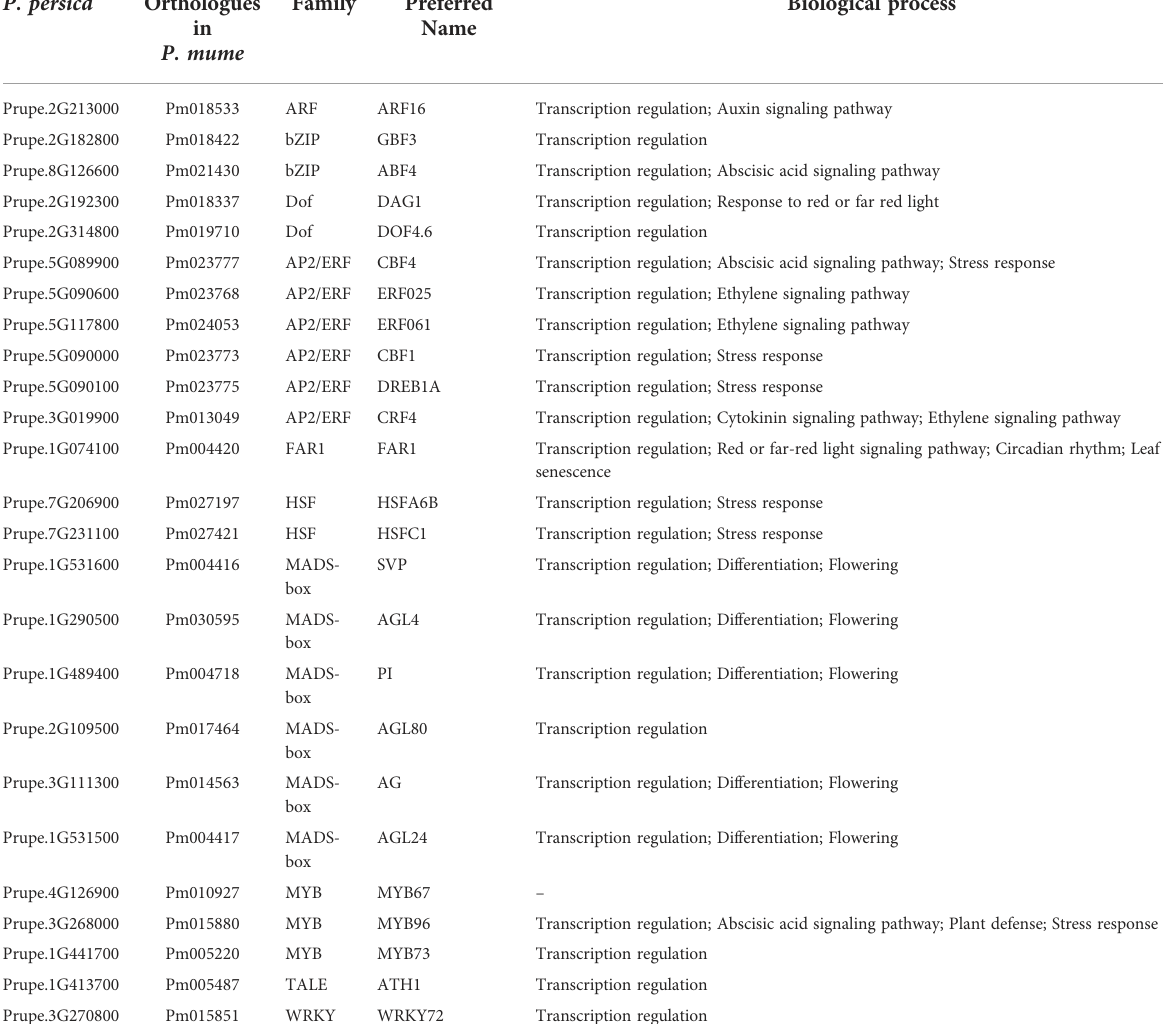
TABLE 1 Identi fi cation and functional annotation of early fl owering-related TFs. P.